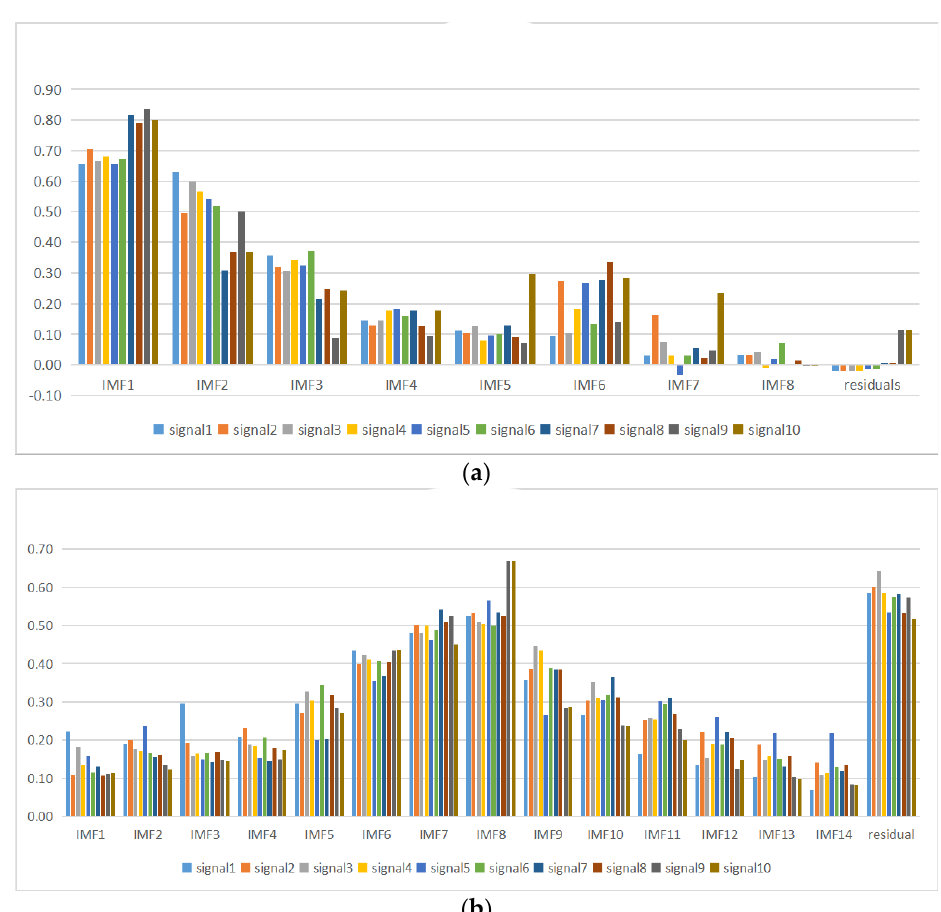
Figure 13. Degree of correlation between ( a ) IMF of EMD and original signal and ( b ) IMF of VMD and original signal.